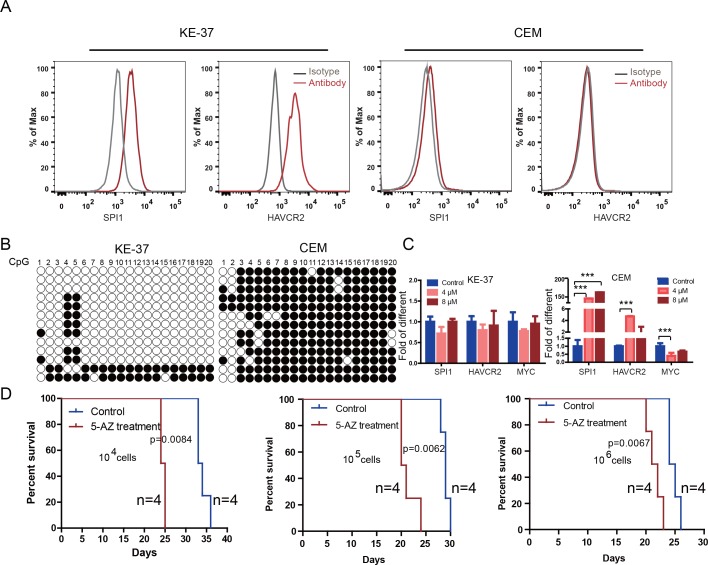
Human SPI1 expression is silenced by DNA methylation(A) FACS analysis shows the surface expression of HAVCR2 and the intracellular level of SPI1 in the human T-ALL cell lines KE-37 and CEM.(B) Methylation status of CpG islands in the SPI1 promoter in the human T-ALL cell lines KE-37 and CEM; (C) q-PCR analysis of SPI1, HAVCR2 and Myc expression in KE-37 and CEM cells without (blue) and with(pink and red) 5-AZ treatment in vitro; (D) Survival curves show T-ALL development by CEM cells without (blue) and with (red) 5-AZ treatment upon transplantation (n = 4; t-test). The data in Care the means ± S.Ds of 3 independent tests; *p≤0.05; **p≤0.01; ***p≤0.001.